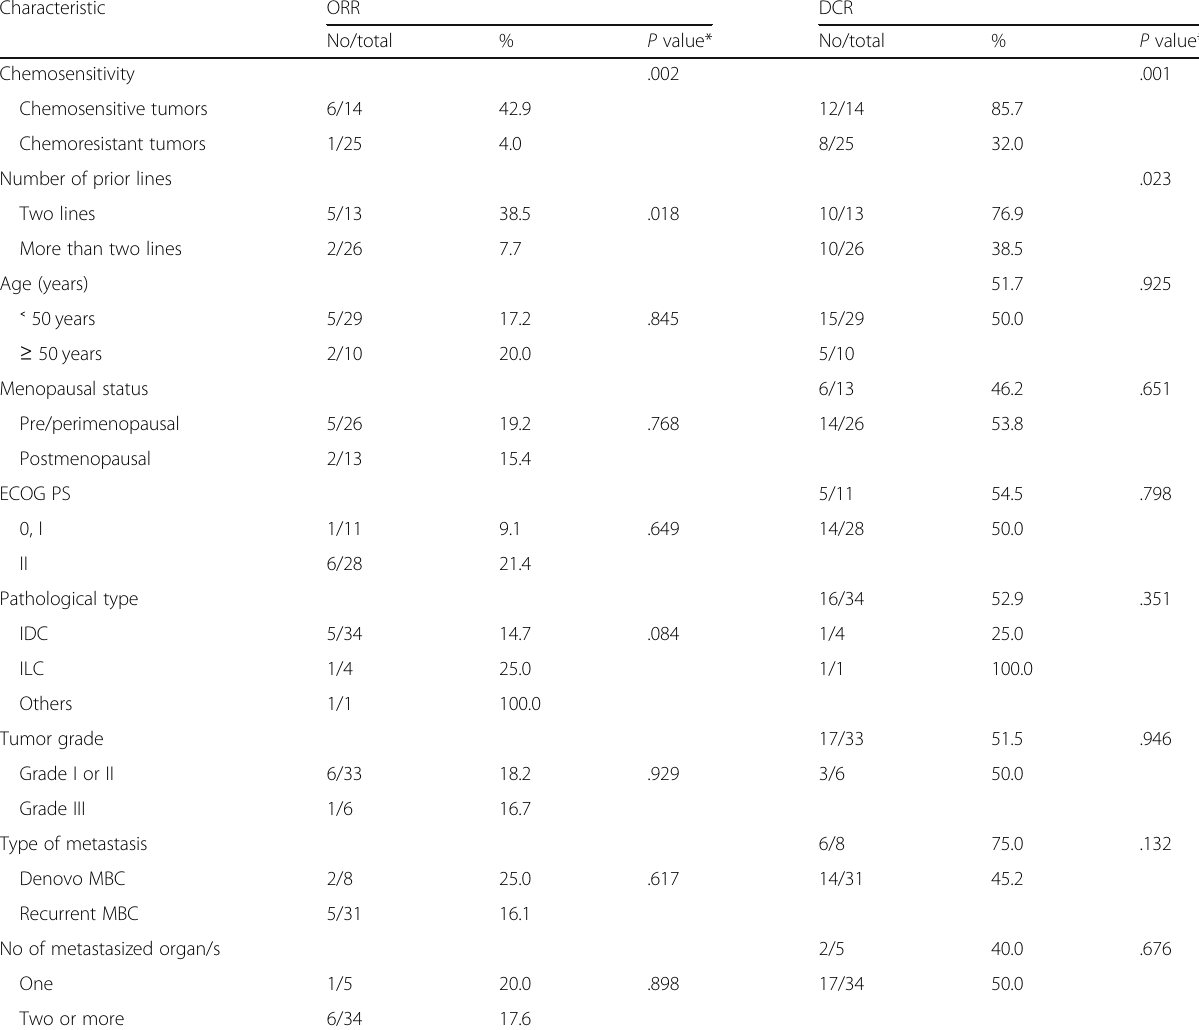
Table 2 Disease control rate and overall response rate according to RECIST Criteria V 1. 1